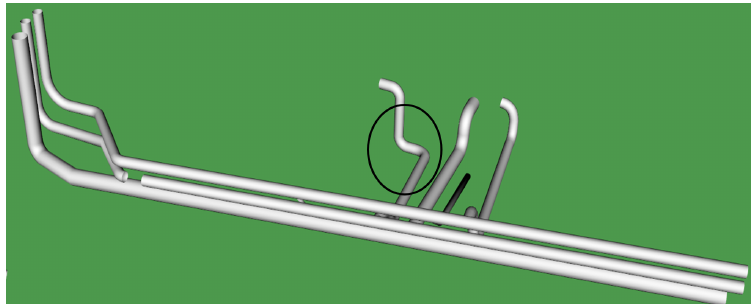
Figure 11. Predefined CAD Model 2.